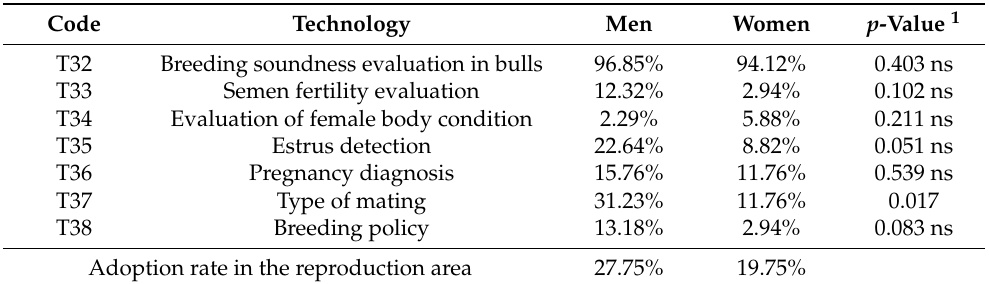
Table 6. Technological adoption rate of men and women in reproductive area (T, technology number).